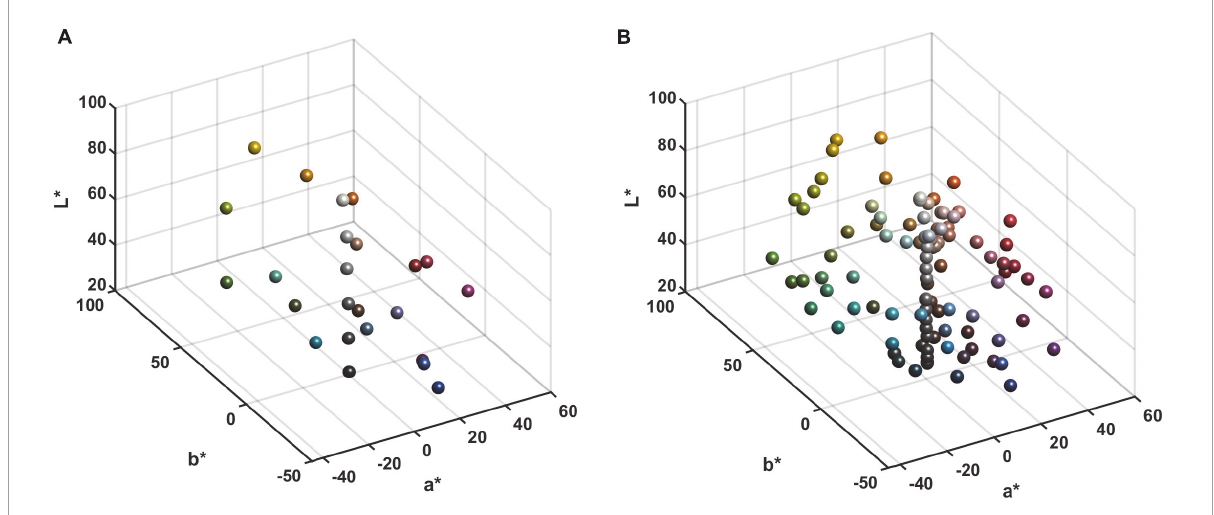
FIGURE4 Distribution of the Xrite ColorChecker chart samples in CIELAB color space: (A) The CC chart. (B) The SG chart.